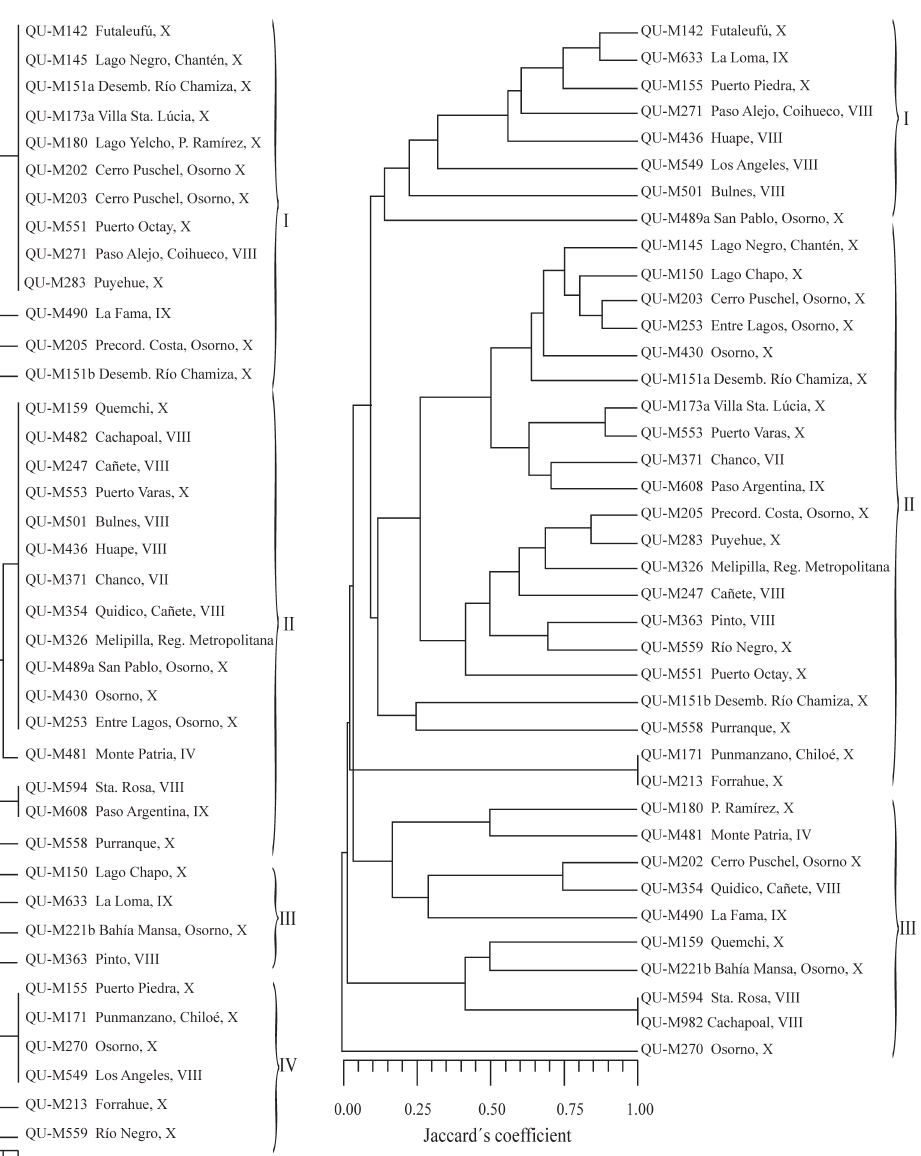
Figure 5 - Dendrogram based on the combined data from the RAPD, SSR and ITS-RFLP analysis of 39 Chilean isolates of Metarhizium anisopliae var. anisopliae .